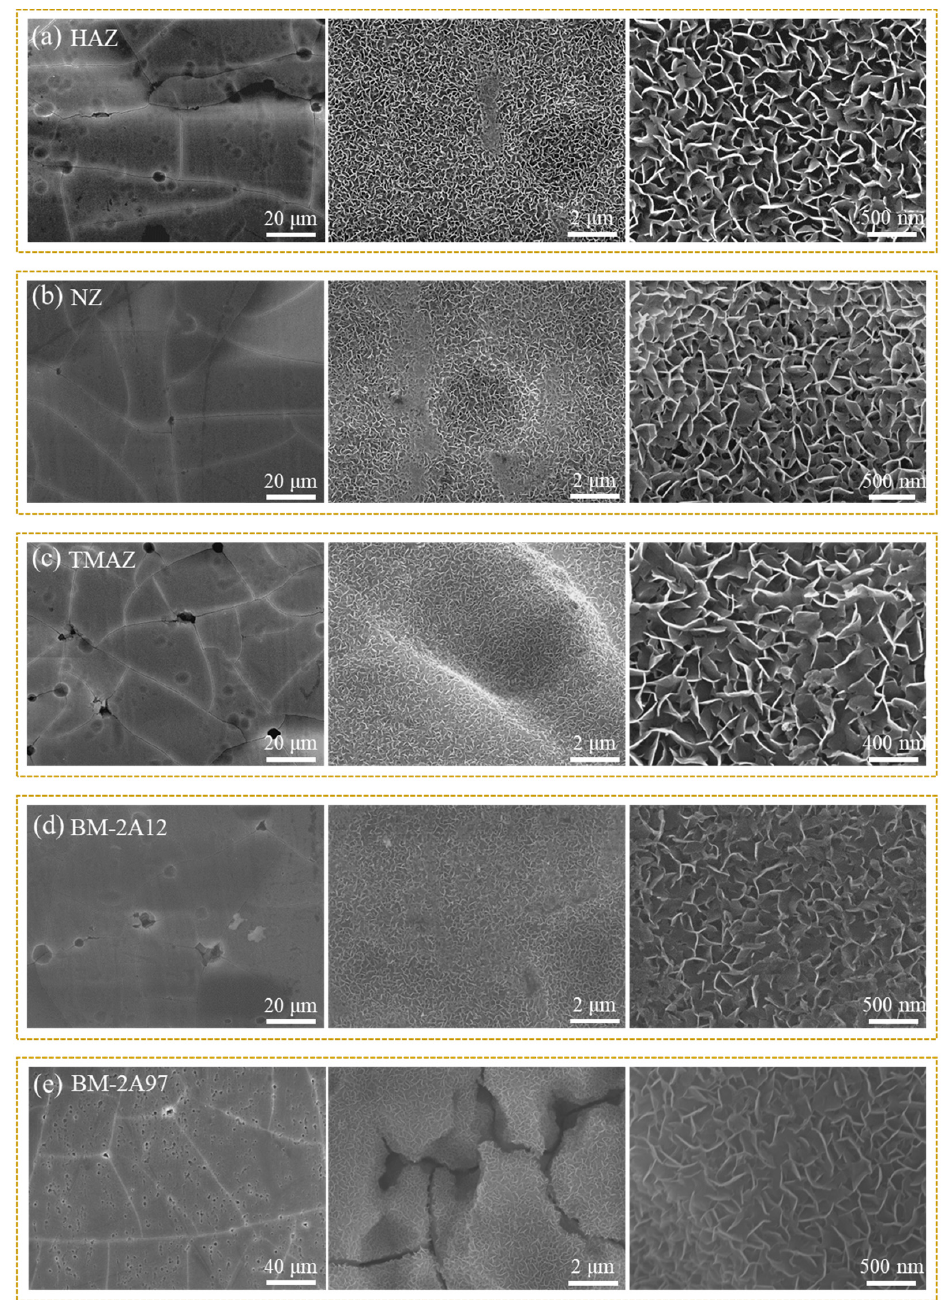
Figure 3. SEM images of the CSA-LDH film on different FSW joint areas. ( a ) HAZ, ( b ) NZ, ( c ) TMAZ, ( d ) BM-2A12 and ( e ) BM-2A97.